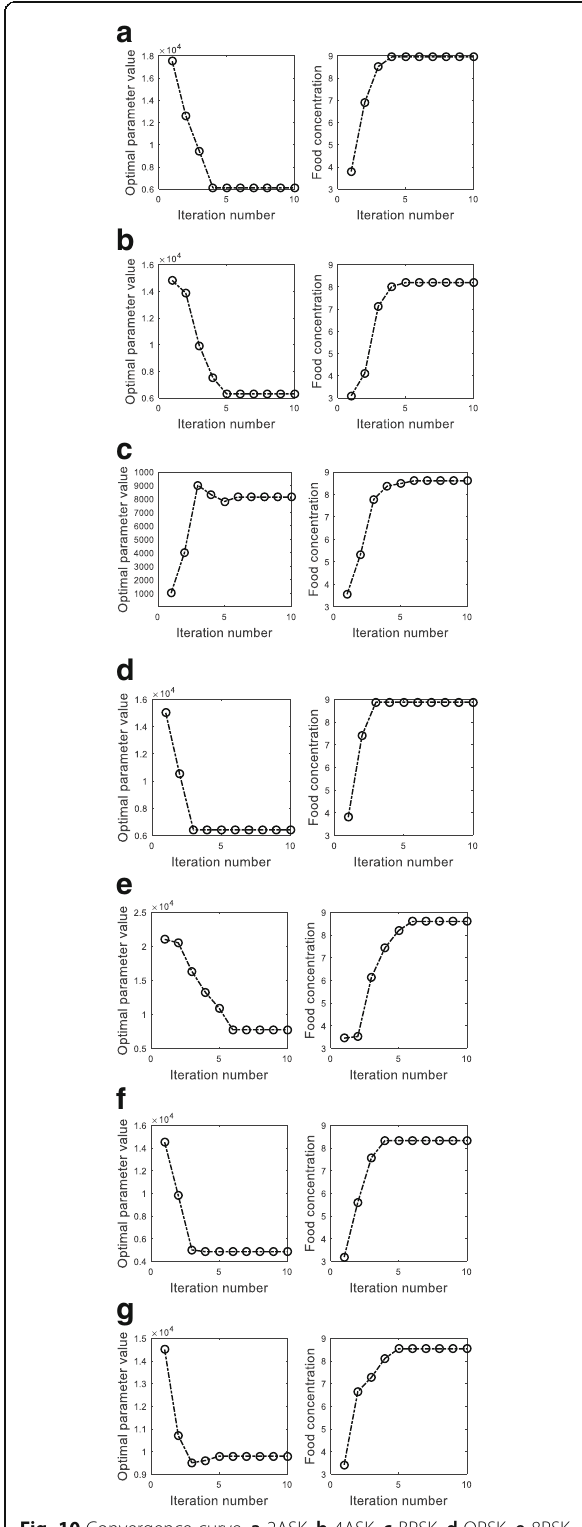
Fig. 10 Convergence curve. a 2ASK. b 4ASK. c BPSK. d QPSK. e 8PSK. f 16QAM. g